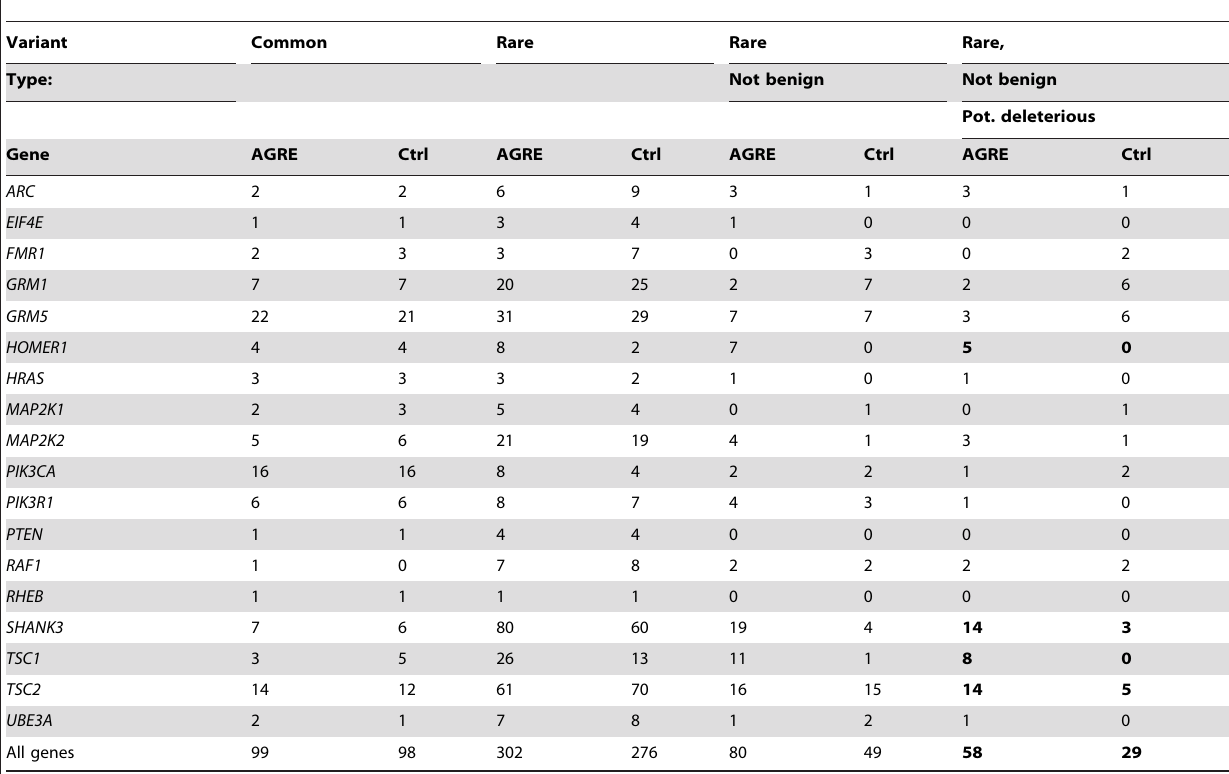
Table 1. Enrichment of rare functional variants in mGluR pathway genes in autism cases detected by high-throughput